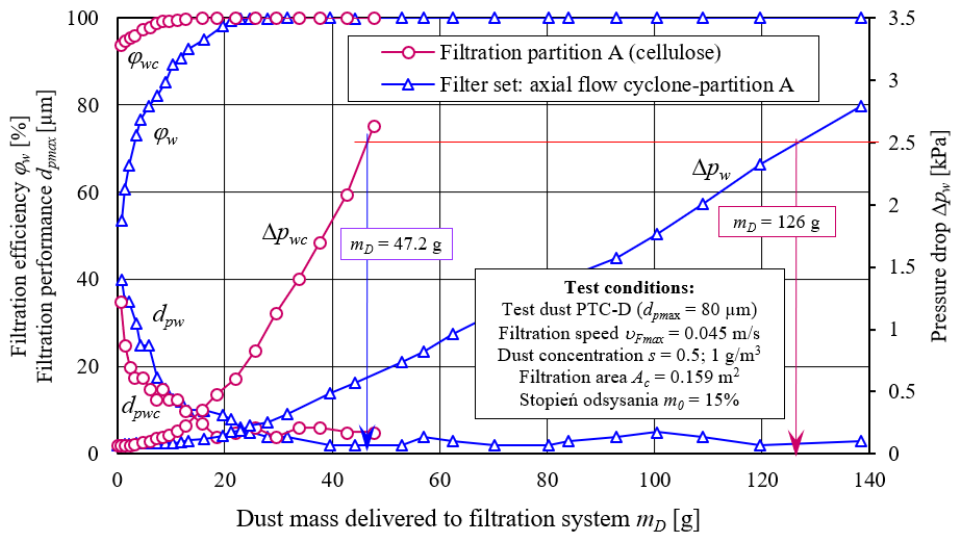
Figure 14. Characteristics: separation efficiency φ w = f ( m D ), pressure drop Δ p w = f ( m D ), filtration performance d pmax = f ( m D ) as dust mass function m D supplied to filter element operating in a single ‐ stage and two ‐ stage system “cyclone–cartridge”.